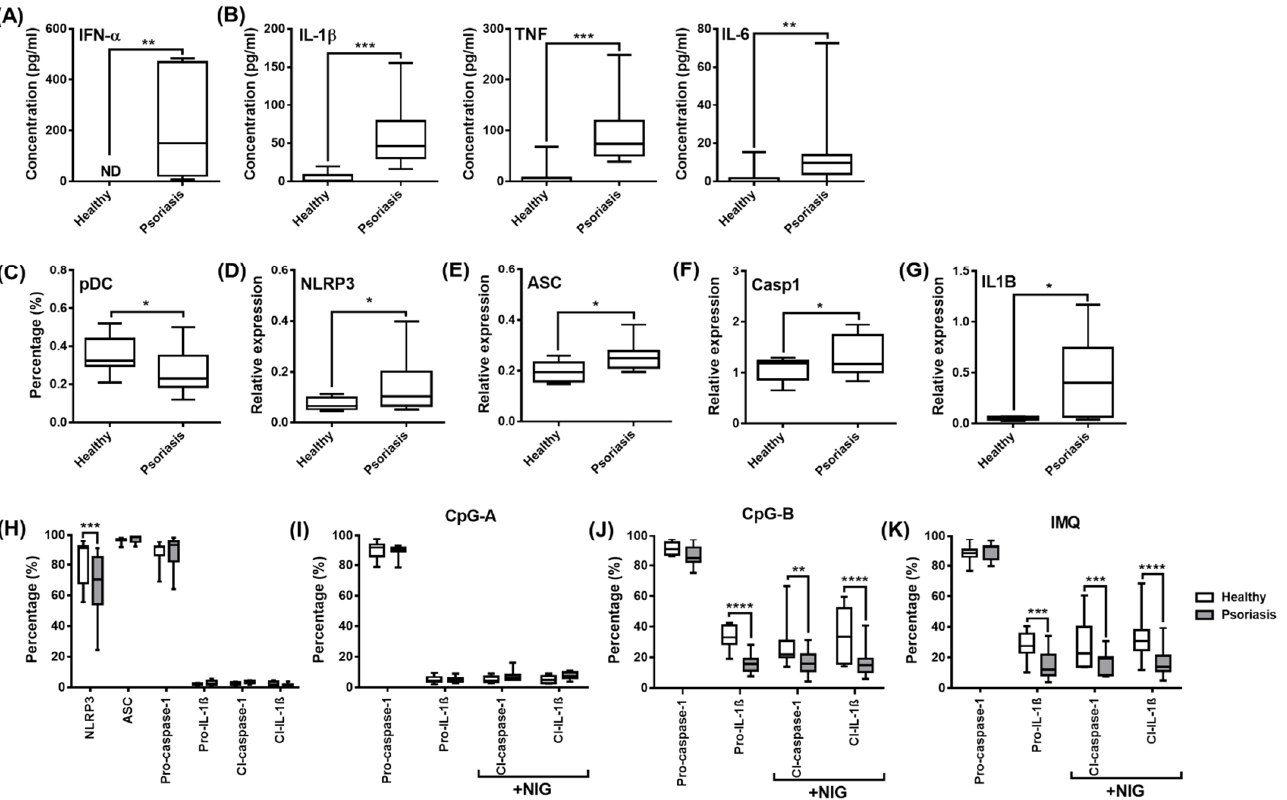
Figure 9. Characteristics of psoriasis patients. Peripheral blood was taken from healthy volunteers and psoriasis patients then PBMCs were separated using Ficoll-Paque gradient centrifugation and blood plasma was stored at -70 ◦ C until analysis. The plasma concentration of IFN- α ( A ), IL-1 β , TNF- α and IL-6 ( B ) was measured by ELISA. The percentage of pDCs was determined by flow cytometry ( C ). The baseline expression level of NLRP3 ( D ) , ASC ( E ), caspase-1 ( F ) and IL1B ( G ) was measured by qPCR in PBMCs. In some experiments PBMCs were left untreated ( H ) or activated with 1 µ M CpG-A, 1 µ M CpG-B or 5 µ g/mL IMQ for 2.5 h ( I – K ), then stimulated with 20 µ M nigericin for 1 h to induce the NLRP3-dependent cleavage of IL-1 β and caspase-1 ( I – K ). The baseline ( H ) and the activation induced ( I–K ) expression of NLRP3 inflammasome pathway components was measured in the gated pDC population by intracellular flow cytometry. Bar graphs represent the mean ± SD of 14 independent experiments. Data were analyzed using paired Student t test ( A – F ) and two-way ANOVA followed by Bonferroni’s post hoc test ( H – K ). * p < 0.05, ** p < 0.01, *** p <